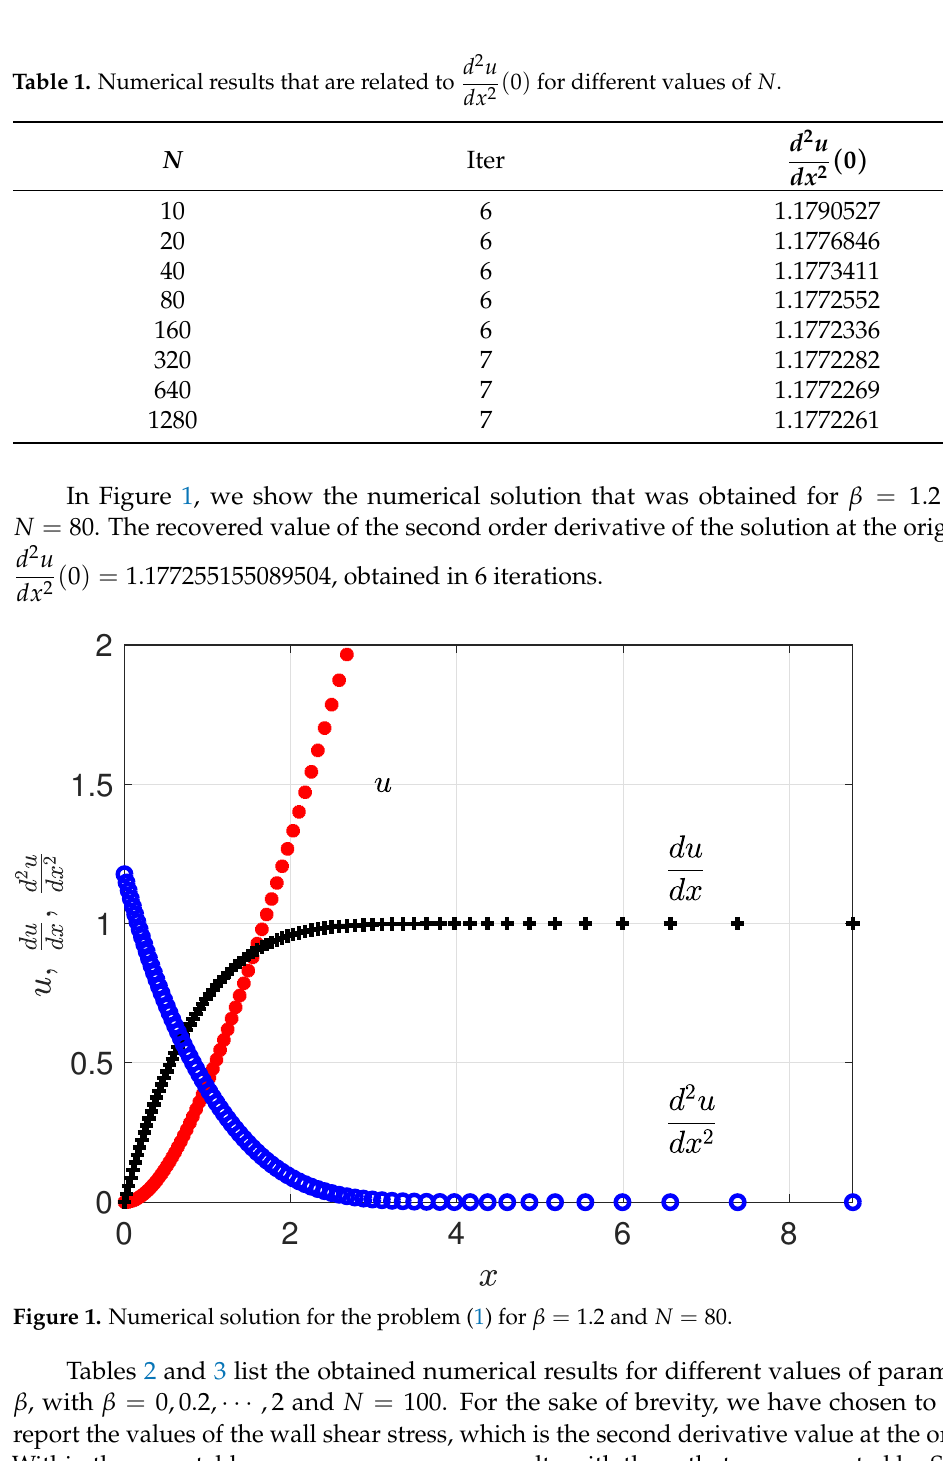
Table 1. Numerical results that are related to